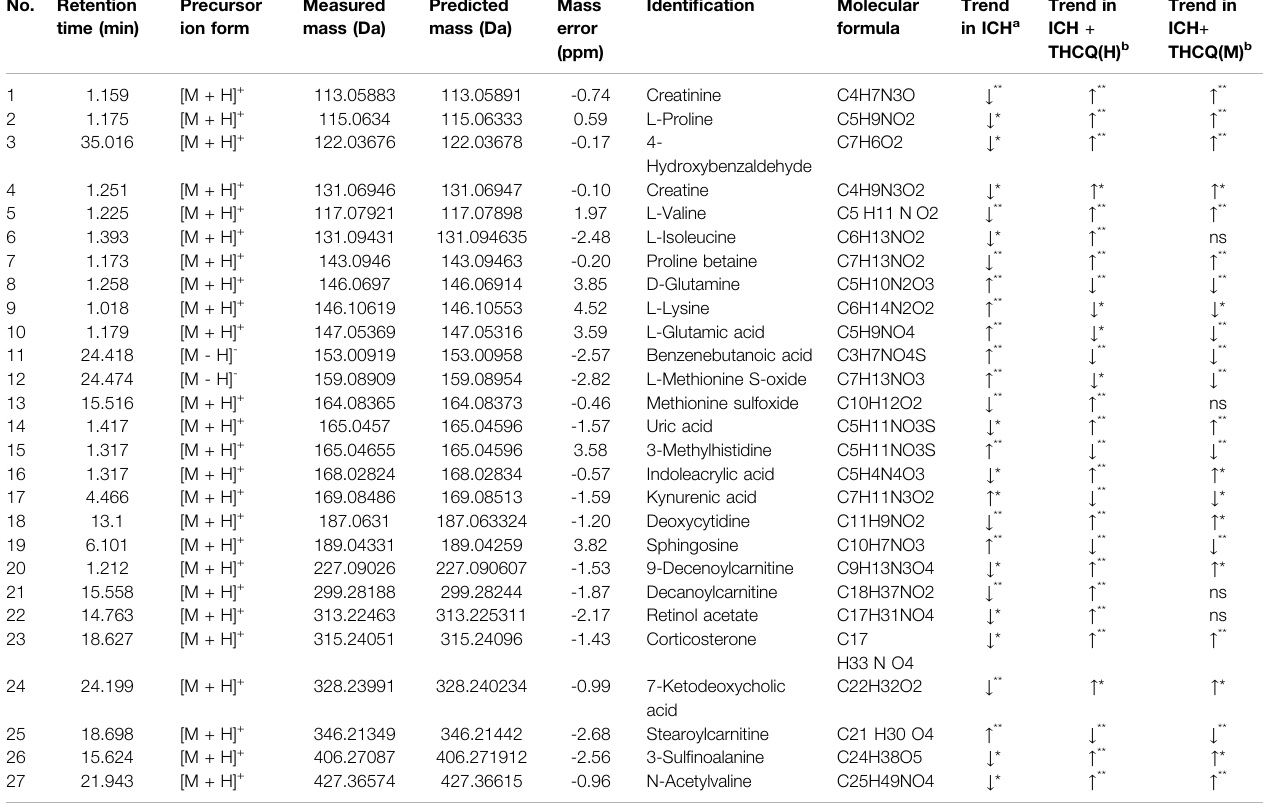
TABLE 1 | Twenty-seven identi fi ed potential biomarkers regulated by Thao-He-Cheng-Qi (THCQ) decoction. No. Retention time (min)